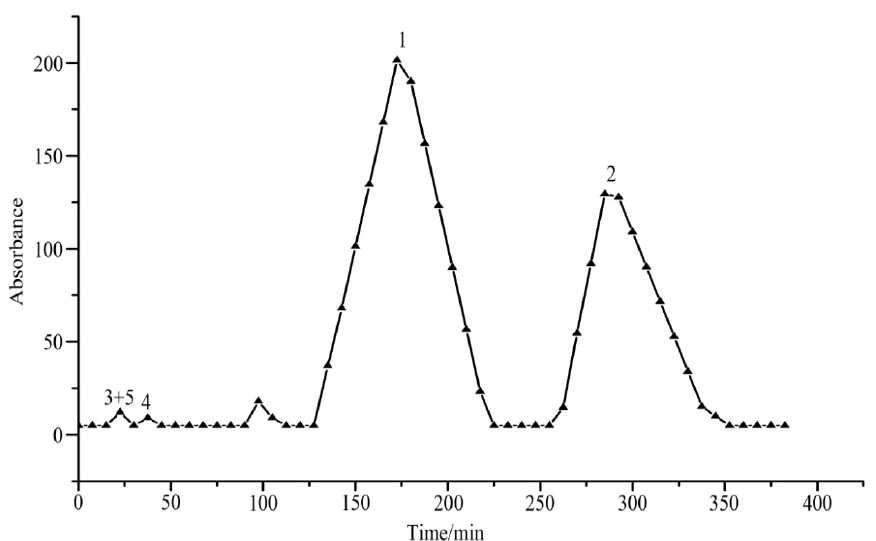
Figure 3. Simulated HSCCC separation chromatogram of Germacrene A fermentation broth by add-